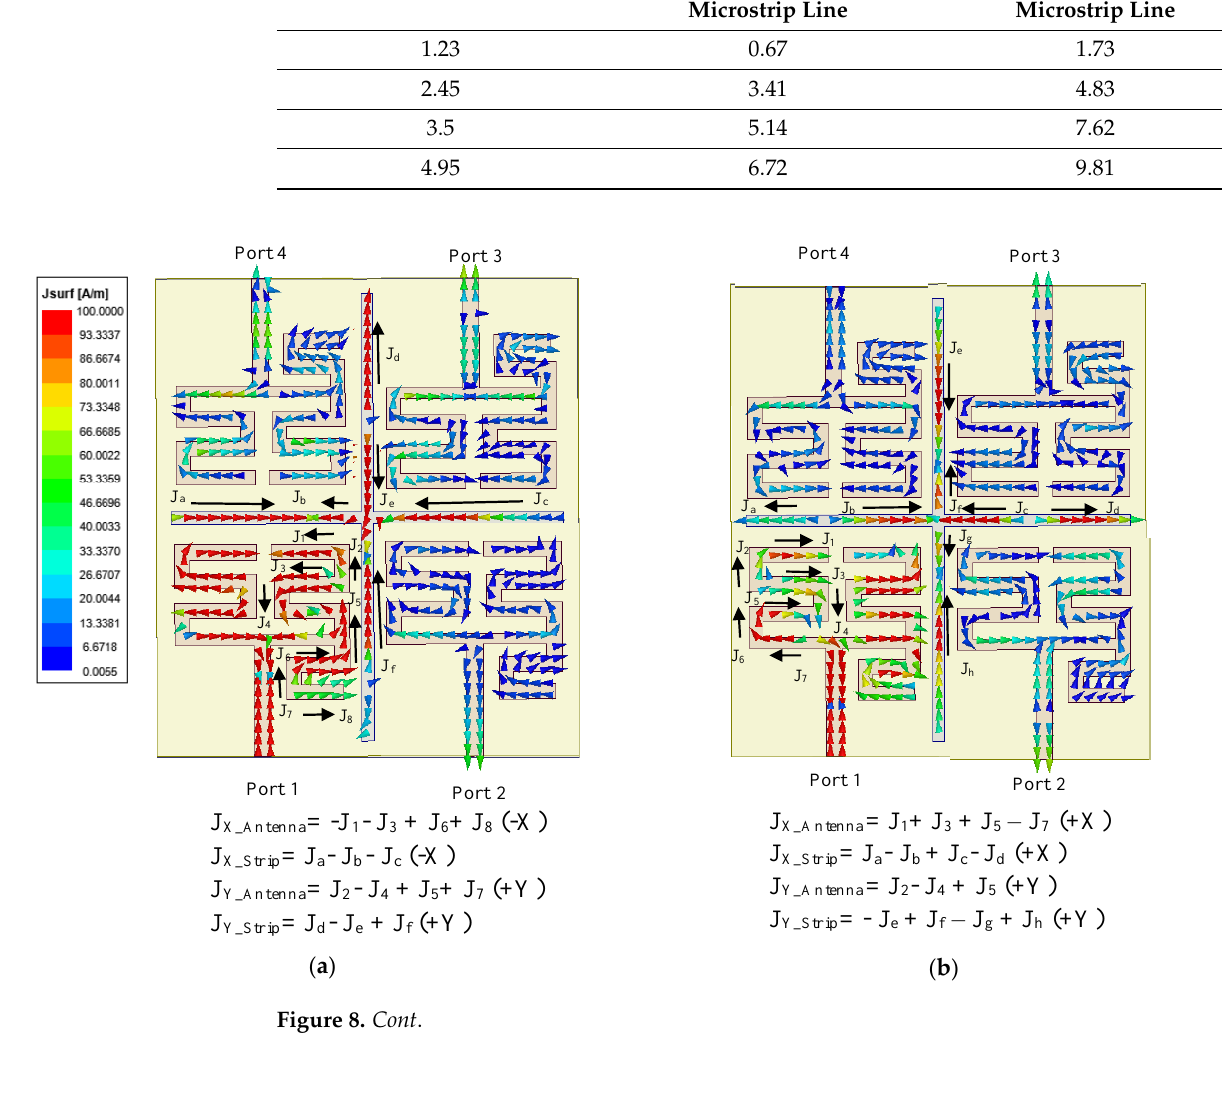
Table 4. Comparison table of gain parameter of the four element MIMO antenna with and without parasitic cross microstrip line. Gain (dB) Frequency (GHz) Without Parasitic Cross With Parasitic Cross Microstrip Line